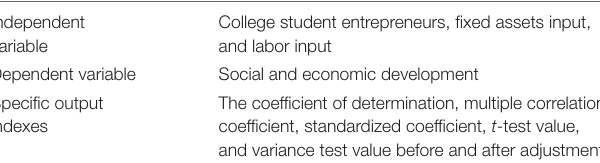
TABLE 2 | Composition of regression analysis indexes.